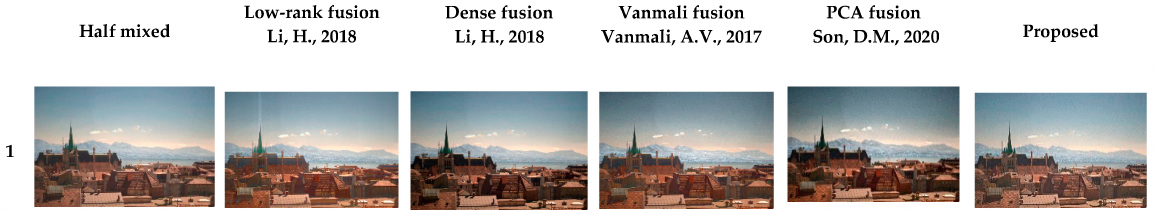
Figure 18. Nighttime input and result images (3): ( a ) visible-light image and near-infrared image, ( b ) Densefuse method result, ( c ) Vanmali method result, ( d ) PCA method result, ( e ) proposed method result.